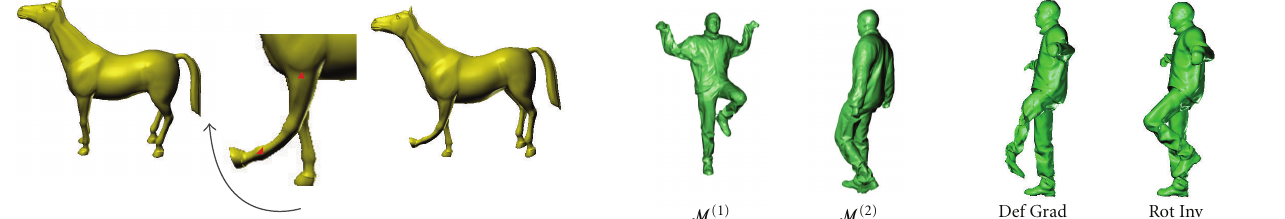
Figure 4: Comparison of interpolation results. We perform inter- polation on two meshes in di ff erent orientations: M (1) and M (2) . The interpolation result using deformation gradients (Def Grad) is distorted because there is an ambiguity for interpolation if the orientations of the triangles di ff er by more than 180 degrees. The result obtained using the rotation-invariant encoding (Rot Inv) does not su ff er from this